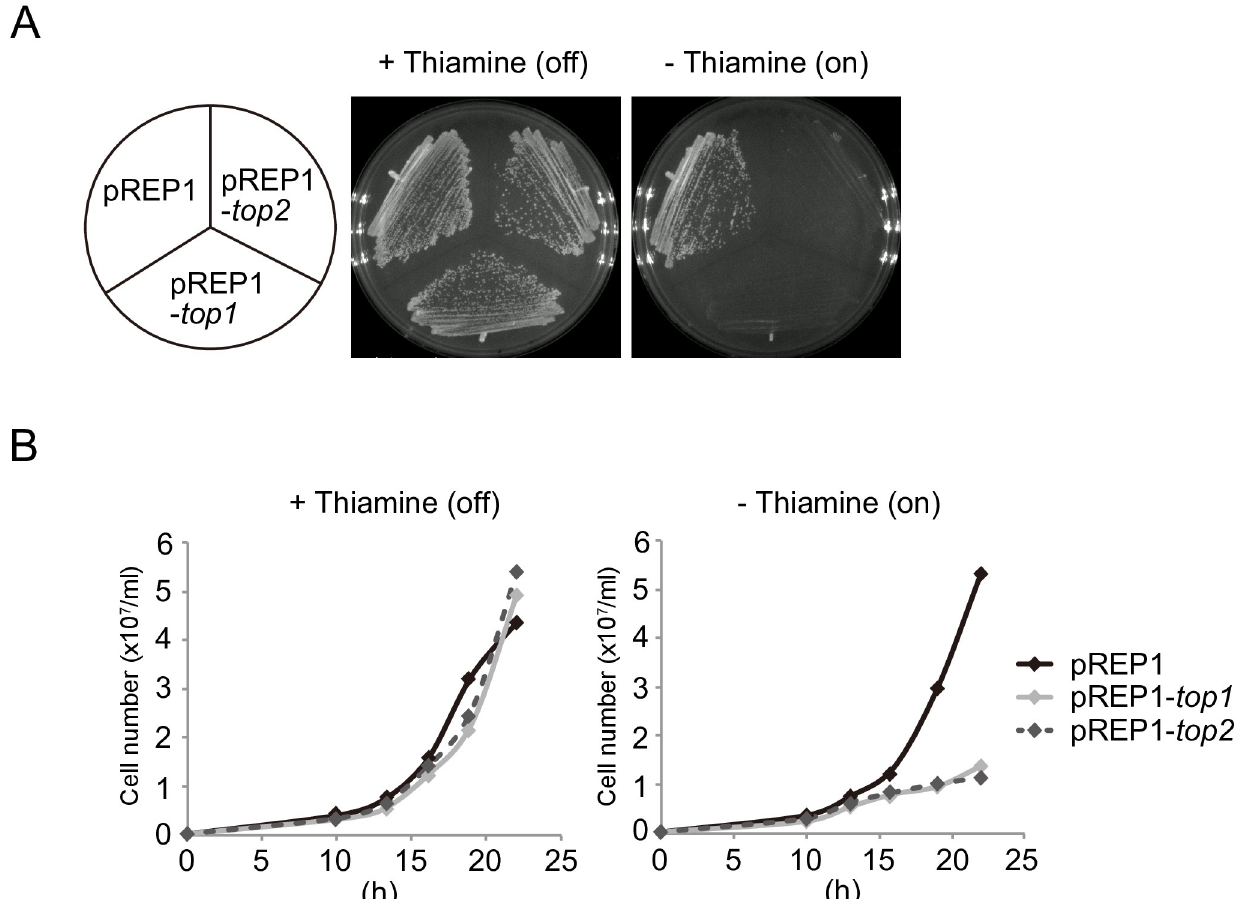
Fig 1. Topoisomerase overexpression is associated with severe growth defect. (A) Single colonies of pREP1-, pREP1- top1 -, and pREP1- top2 -carrying cells were streaked to thiamine-containing SD medium (repressive conditions) or thiamine-free MM (inducing conditions) and incubated for 3 days at 30˚C. (B) Growth of pREP1-, pREP1- top1 -, and pREP1- top2 -carrying cells. Cells were pre-cultured in SD medium and grown to mid-log phase. After washing, the cells were transferred to SD medium or MM and cultured at 30˚C.